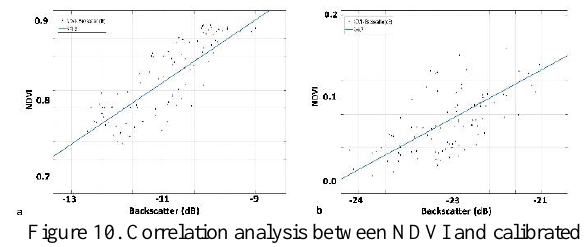
Figure 7. Comparison of the areal extents of the forest destruction mapped by different methods. (a) SAR intensity image differencing (b) SVM Classification (c) CORINE LULC data.